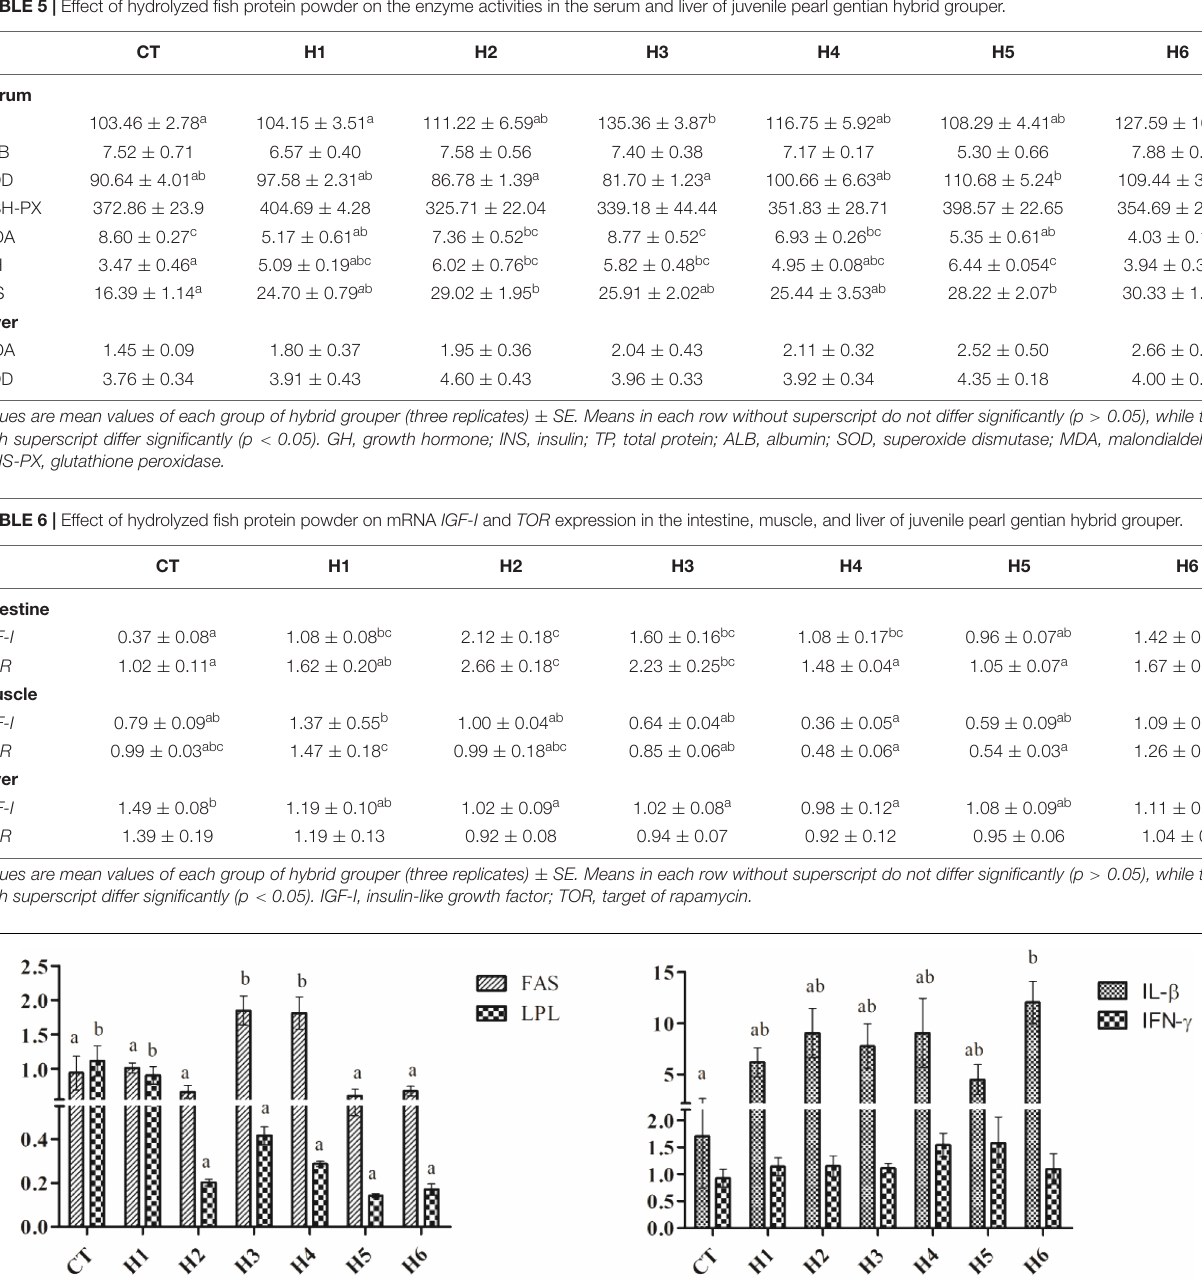
TABLE 5 | Effect of hydrolyzed fish protein powder on the enzyme activities in the serum and liver of juvenile pearl gentian hybrid grouper.